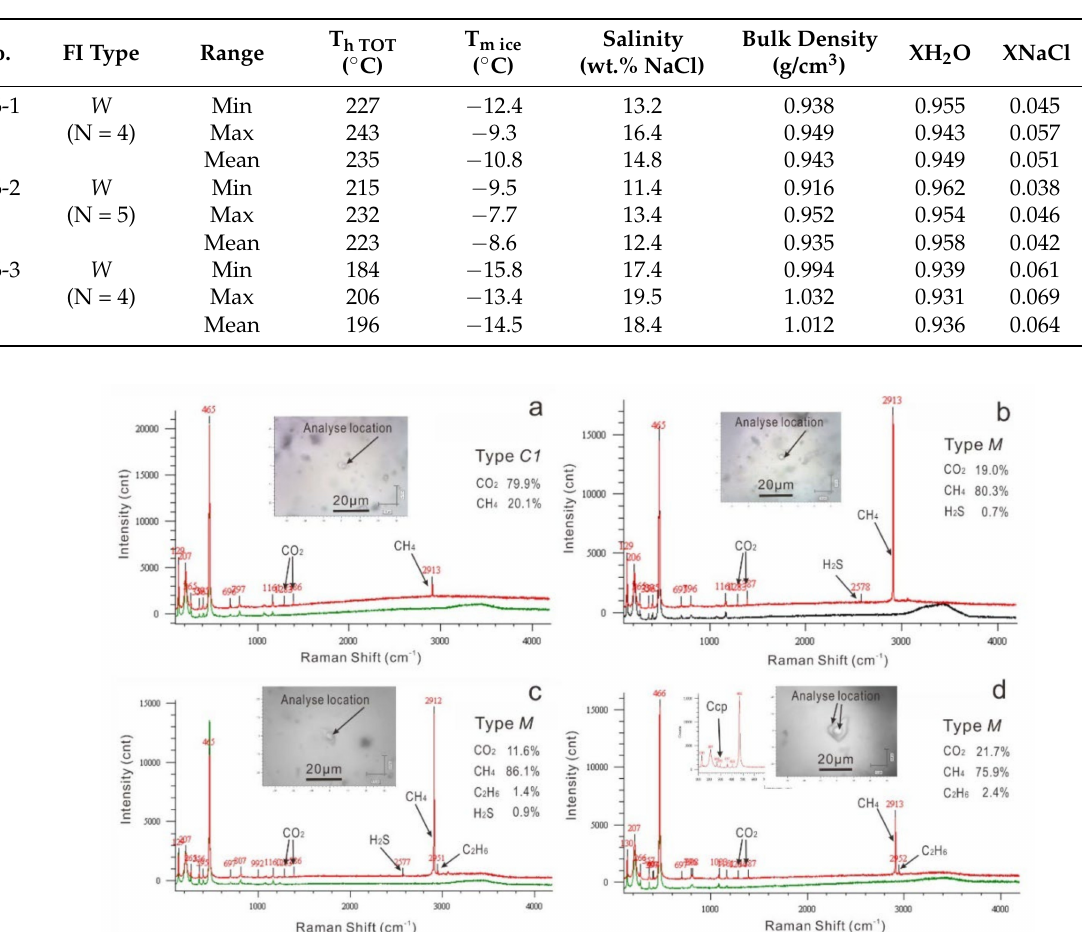
Table 5. Summary of the microthermometric data and calculated parameters for Group 6 FIAs from stage IV quartz.